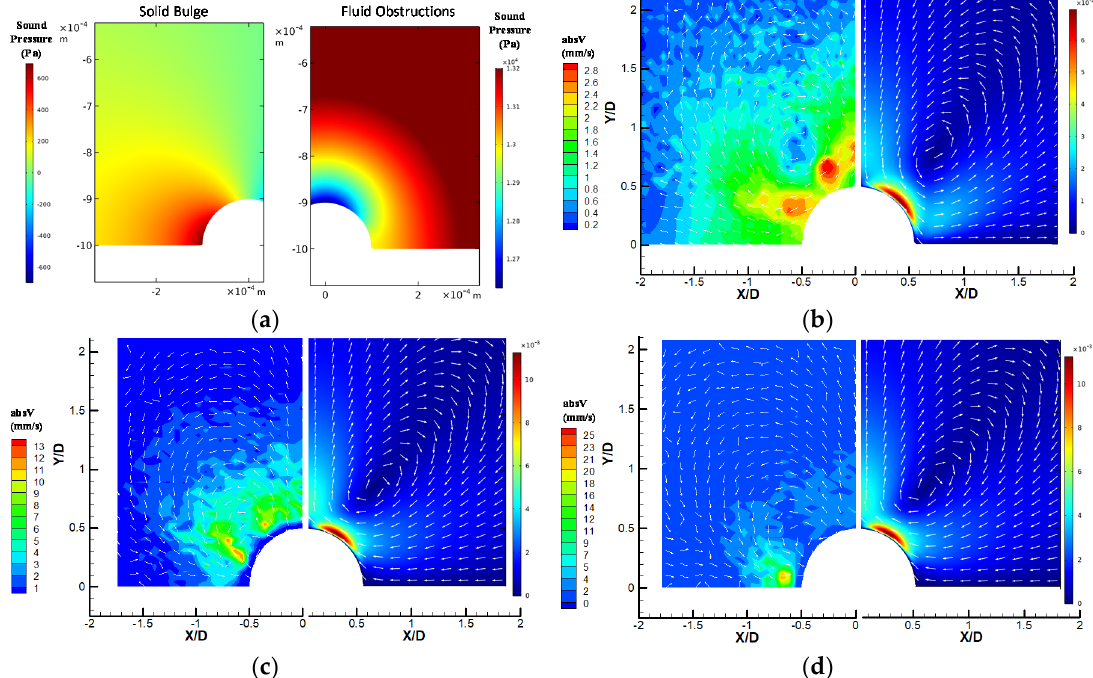
Figure 18. Numerical simulation results and comparisons to experimental results: ( a ) acoustic pressure distribution of the solid bulge (left) and fluid obstruction case (right); ( b – d ) side-by-side comparisons of distributions of streaming velocity vector and absolute velocities (absV) of ( b ) solid, ( c ) liquid droplet and ( d ) gas bubble obstruction. Experimental results are on the right side and numerical simulations are on the left side in each subplot.